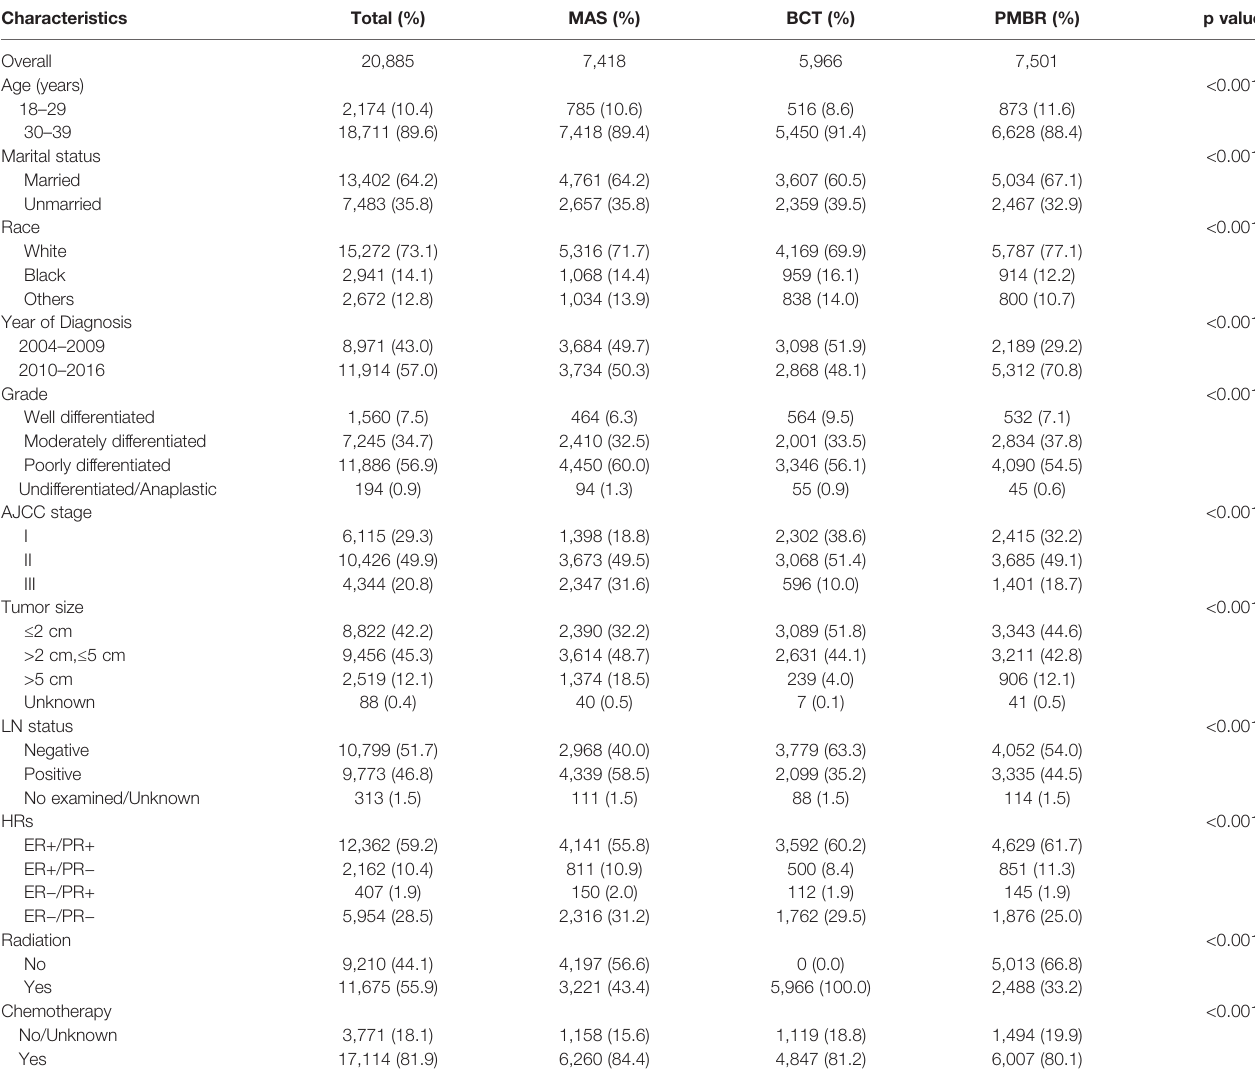
TABLE 1 | Comparison of baseline characteristics of operable breast cancer among various surgical